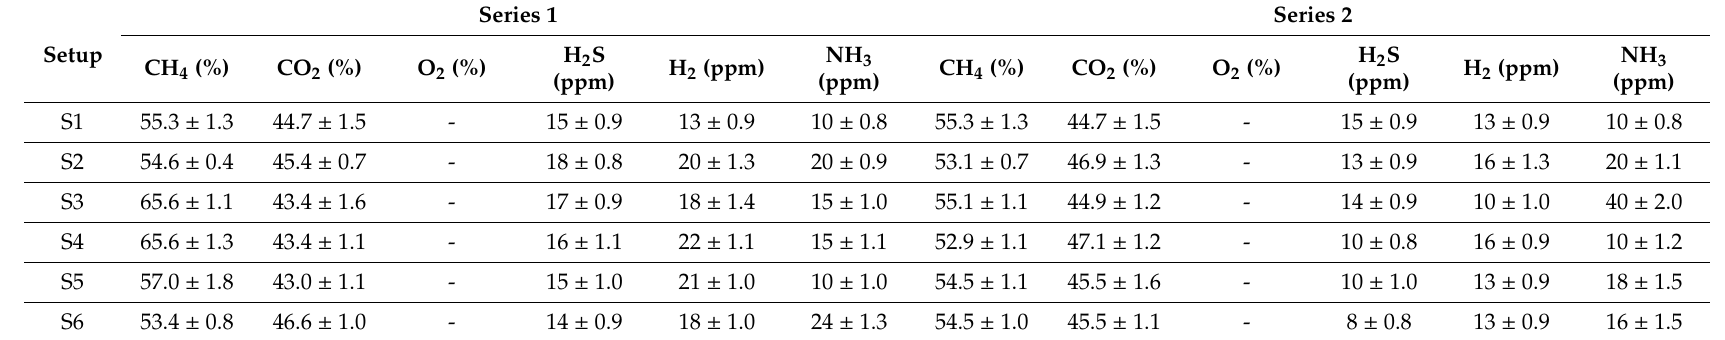
Table 6. Biogas composition in experimental setups